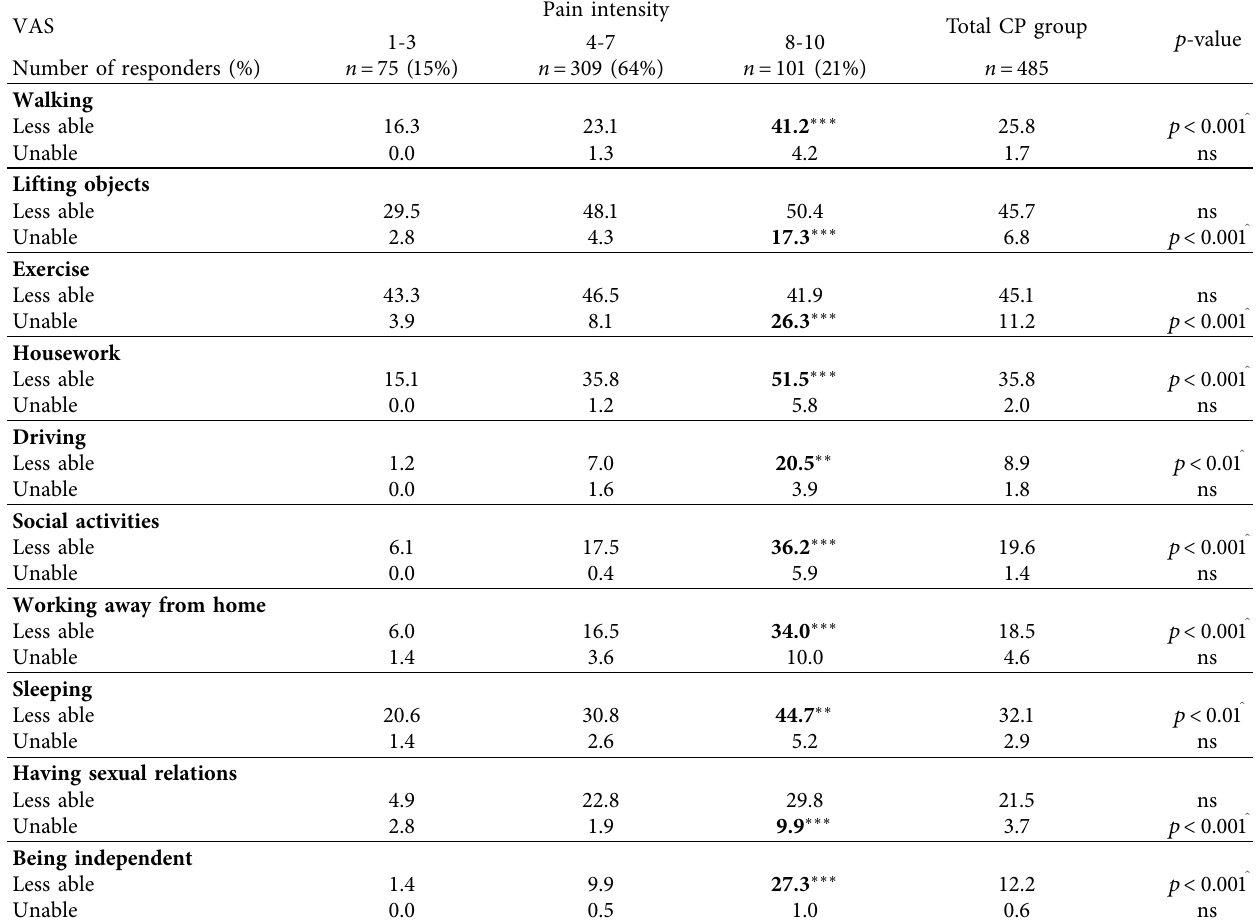
Table 3: Life quality indices of pain intensity